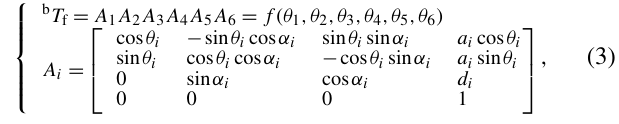
placement sensor and the measured panel surface is D e